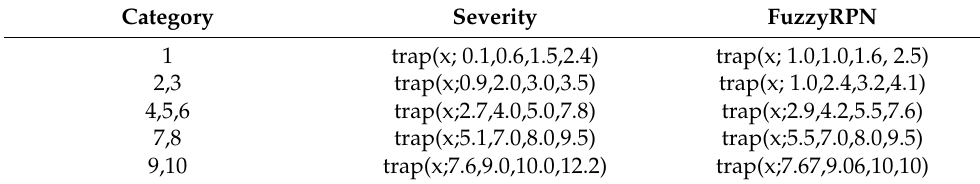
Table 7. Type-I trapezoid membership functions for the FMECA risk